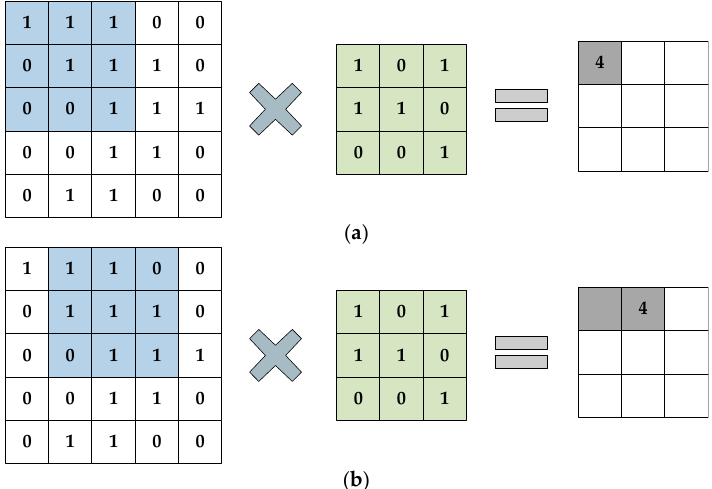
Figure 4. The process of convolutional neural network computation: ( a ) Computation in the first step; ( b ) Computation in the second step.